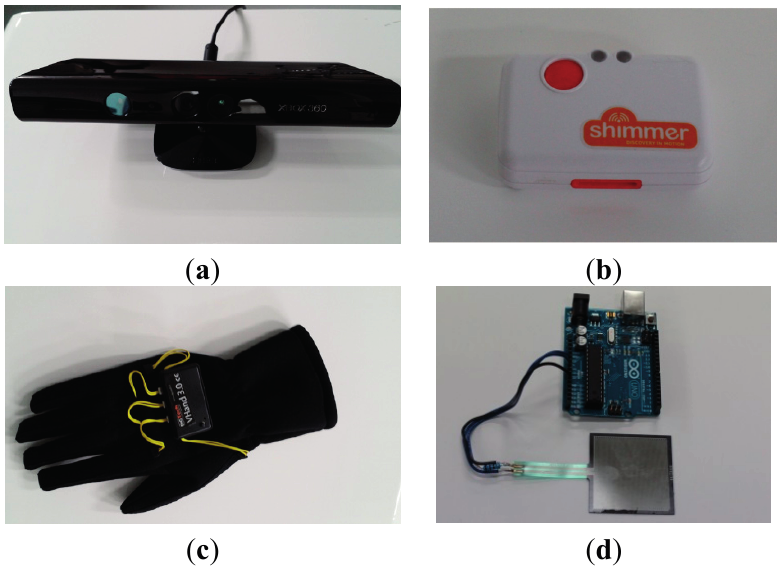
Figure 3. The main sensors we used to record movement with our system. The Kinect